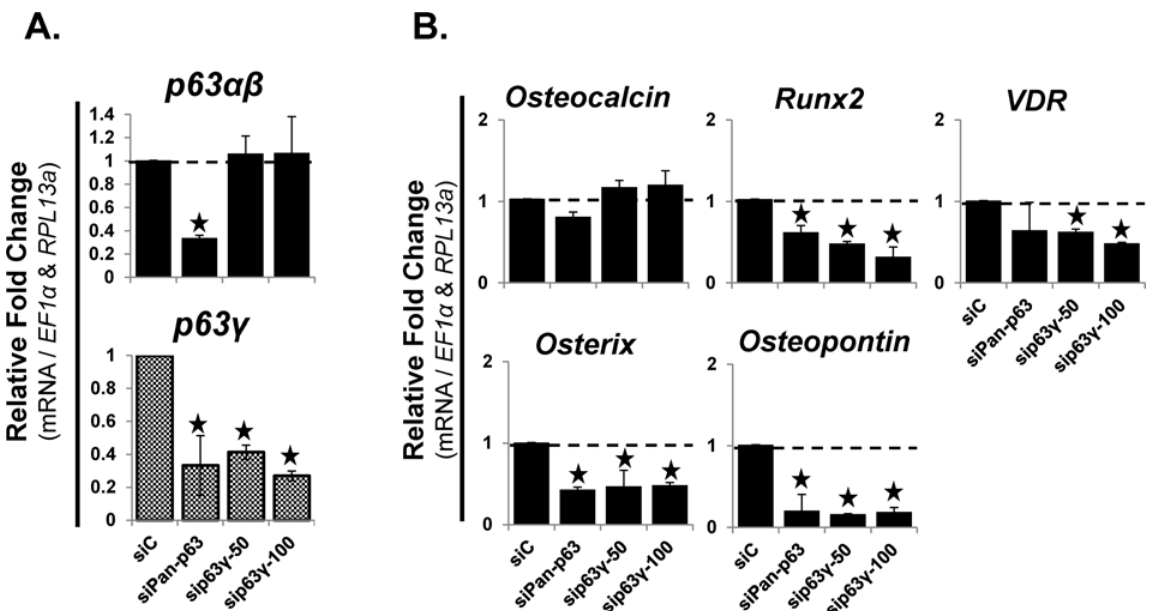
Fig 7. Targeted knockdown of p63 γ variants decreased the mRNA expression of VDR, osterix, runx2 and osteopontin. Knockdown of total p63 (siPan-p63; 50nM) or the p63 γ (TAp63 γ & Δ Np63 γ ) splice variants (sip63 γ ; 50nM or 100nM) in hMSC was done using transfection with siRNA (3 days). Osteogenic differentiation media was added on day-3 for 4 additional days; therefore, cells were collected 7 days post siRNA transfection. A) RT-qPCR analysis of mRNA expression of p63 splice variants (top panel, p63 α / β , bottom panel p63 γ ). RT-qPCR analysis of mRNA expression demonstrated the relative level of knockdown of the p63 splice variants by siPan-p63 & sip63 γ compared to a scrambled control (siC). B) RT-qPCR analysis of mRNA expression of osteoblastic differentiation markers: VDR (vitamin D 3 receptor (binds 1 α ,25-dihydroxyvitamin D 3 )), Osteocalcin , Osterix , Osteopontin , Runx2 and BSP . No change was observed for BSP (data not shown). Alkaline phosphatase staining was also performed but no change was observed (data not shown). N = 3 independent experiments in duplicate. ( * ) p (cid:1) 0.05 compared to control (siC) which were set to the value of “ 1 ” . hMSC used were from a 22 year old